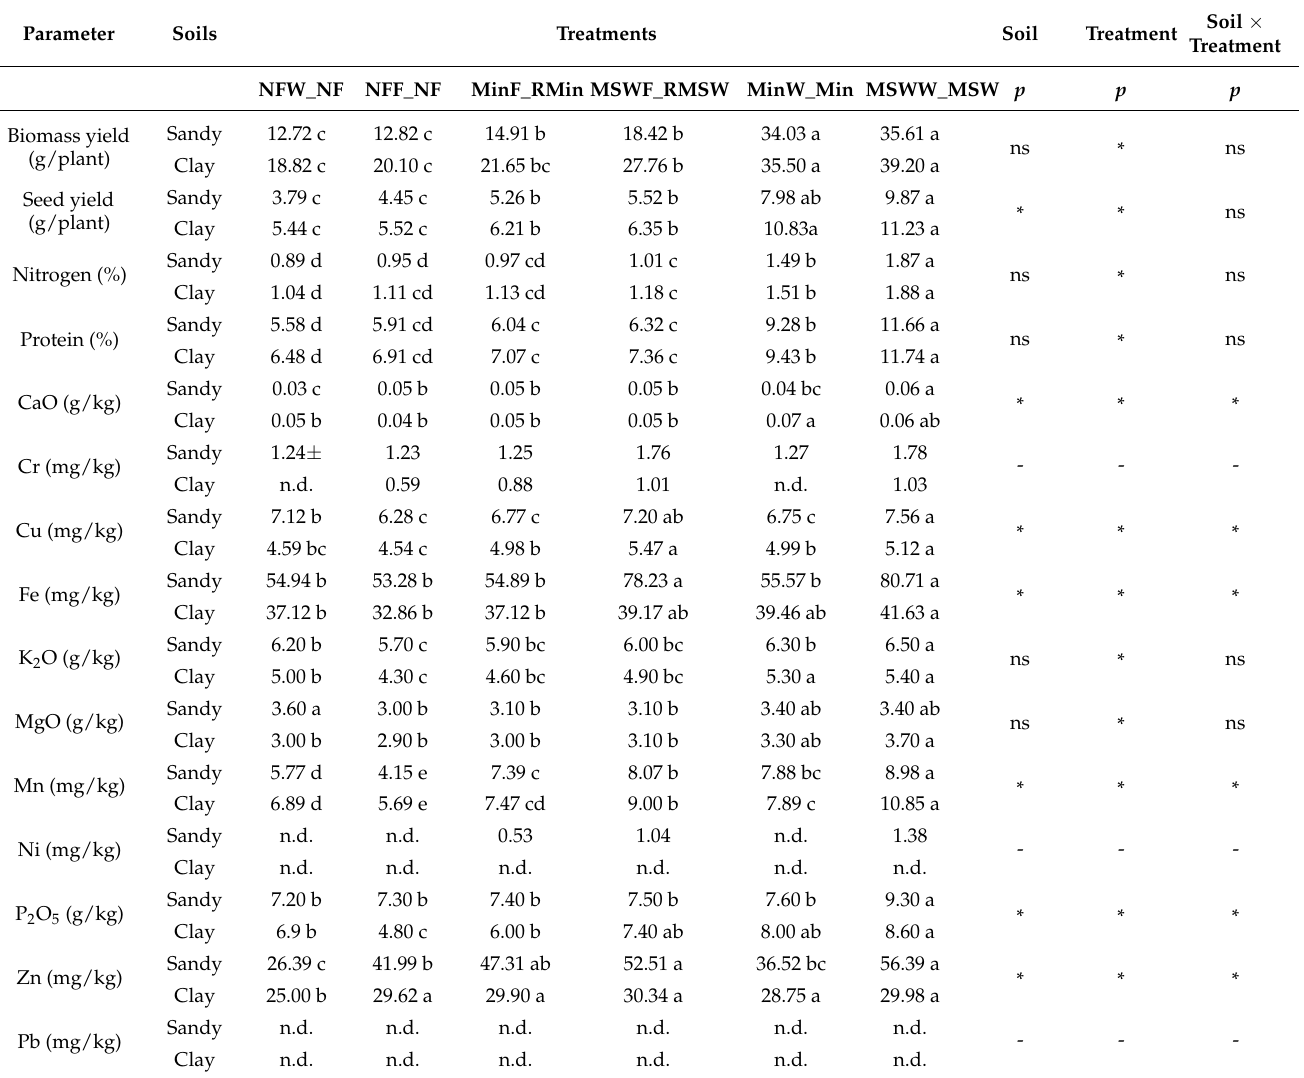
Table 3. Effect of organic fertilization with bio-stabilized MSW amendment and mineral fertilization on buckwheat yield, seed yield, quality, and nutrient content (n.d.: no detection). Factors’ effect over the measured variables was assessed as not significant (ns) or statistically significant (*) for p < 0.05 (mean values with different letters in the same row vary